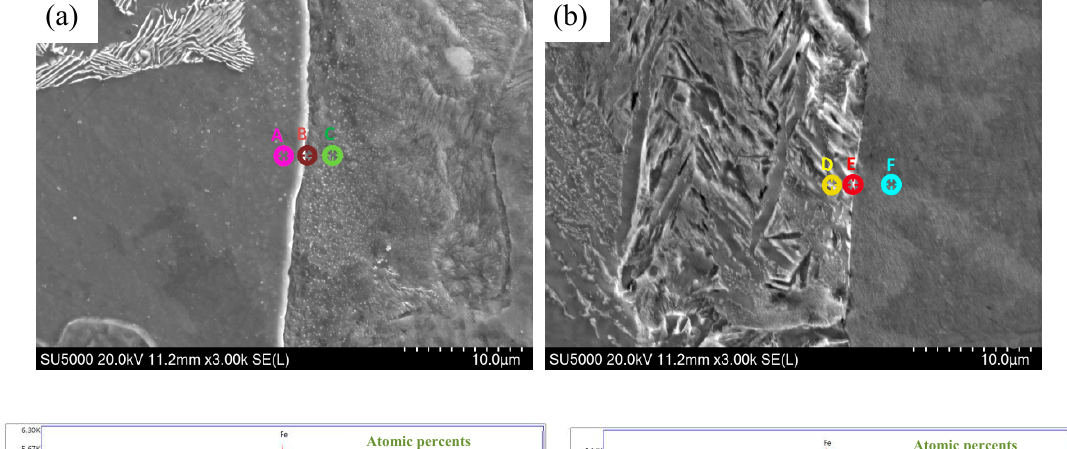
Figure 8. EDS line scan analysis of the 45 steel/copper bimetallic interface.